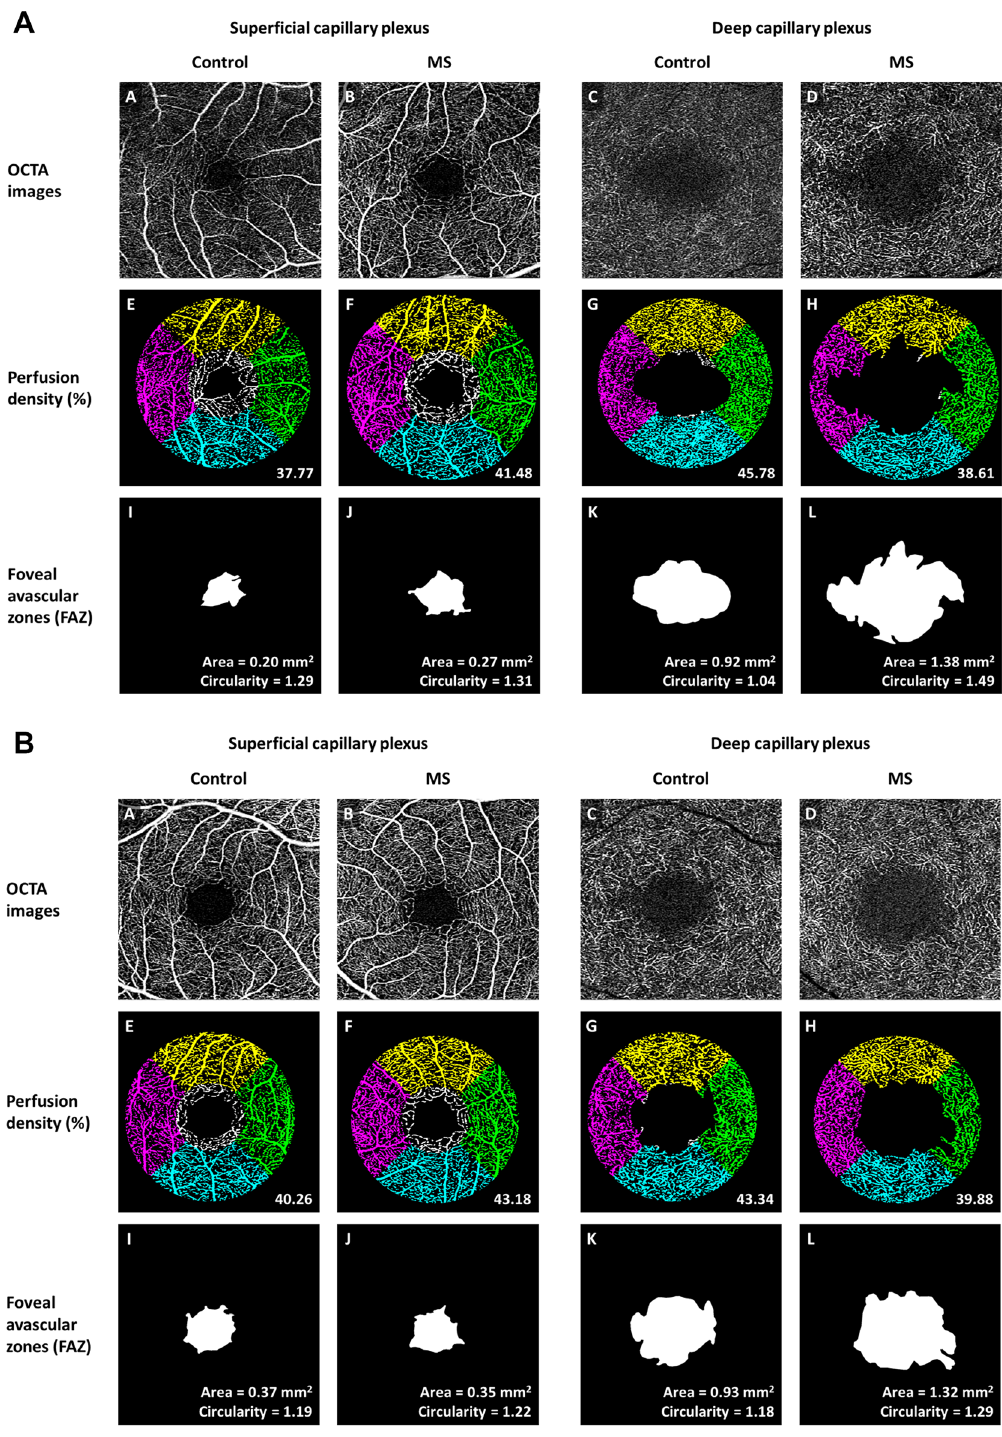
Figure 3. ( A ) Optical coherence tomography angiography (OCTA) images of the superficial capillary plexus (SCP; A,B) and deep capillary plexus (DCP; C,D) extracted from the OCTA machine. (E–H) Perfusion density (PD) maps of the macular annulus region, showing retinal vasculature in controls (E,G) and MS participants (F,H). MS participants showed increased PD in the SCP and decreased PD in the DCP compared to controls. (I-L) Foveal avascular zones (FAZ) delineated from the SCP and DCP, showing FAZ features in controls (I,K) and MS participants (J,L). MS participants showed larger and less circular FAZ than controls only in the DCP, and not in the SCP. ( B ) Optical coherence tomography angiography (OCTA) images of the superficial capillary plexus (SCP; A,B) and deep capillary plexus (DCP; C,D) extracted from the OCTA machine. (E,H) Perfusion density (PD) maps of the macular annulus region, showing retinal vasculature in controls (E,G) and MS participants (F,H). MS participants showed increased PD in the SCP and decreased PD in the DCP compared to controls. (I–L) Foveal avascular zones (FAZ) delineated from the SCP and DCP, showing FAZ features in controls (I,K) and MS participants (J,L). MS participants showed larger and less circular FAZ than controls only in the DCP, and not in the